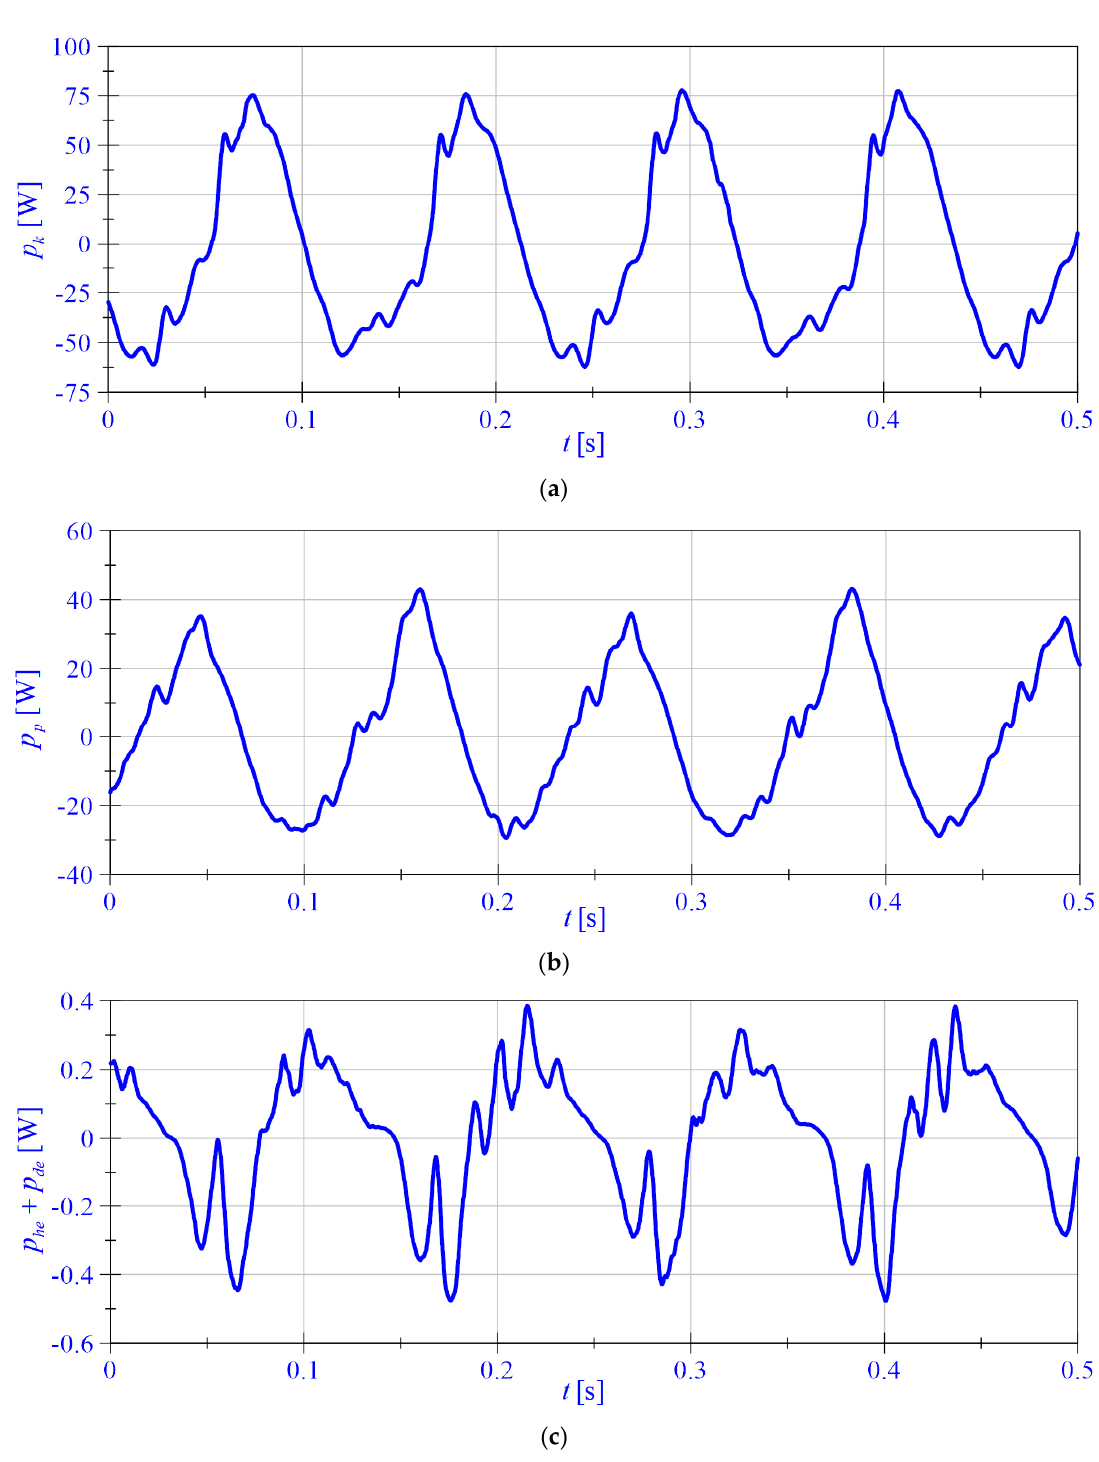
Figure 9. Time histories of power: ( a ) (cid:1868) (cid:3038) ; ( b ) (cid:1868) (cid:3043) ; ( c ) (cid:1868) (cid:3035)(cid:3032) + (cid:1868) (cid:3031)(cid:3032) .